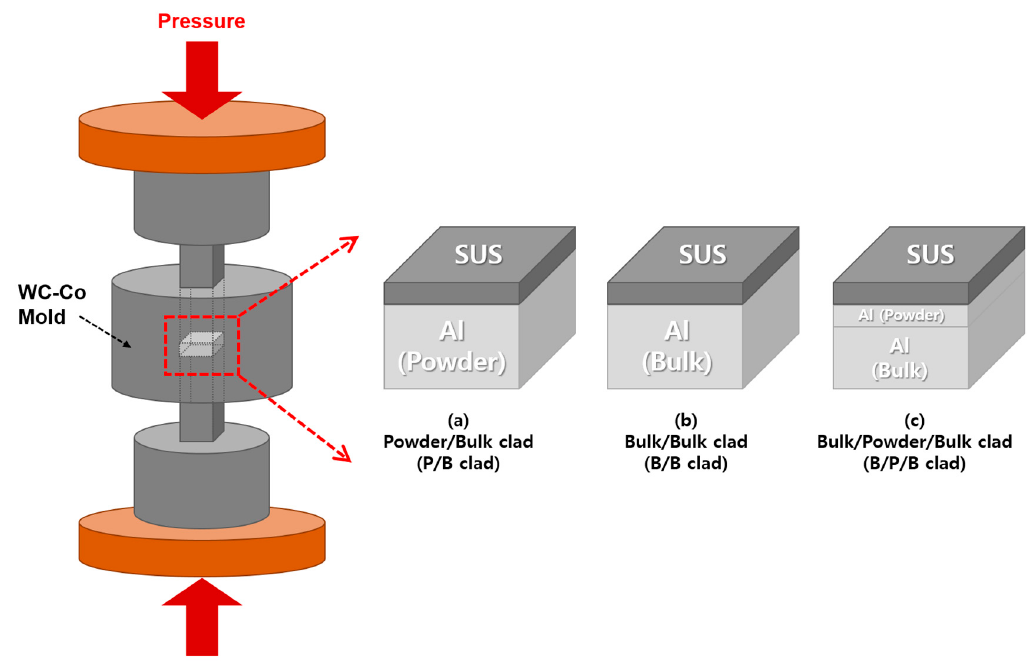
Figure 1. Schematic diagram of spark plasma sintering (SPS) and 3 kinds of aluminum / stainless steel (Al/SUS) clads.